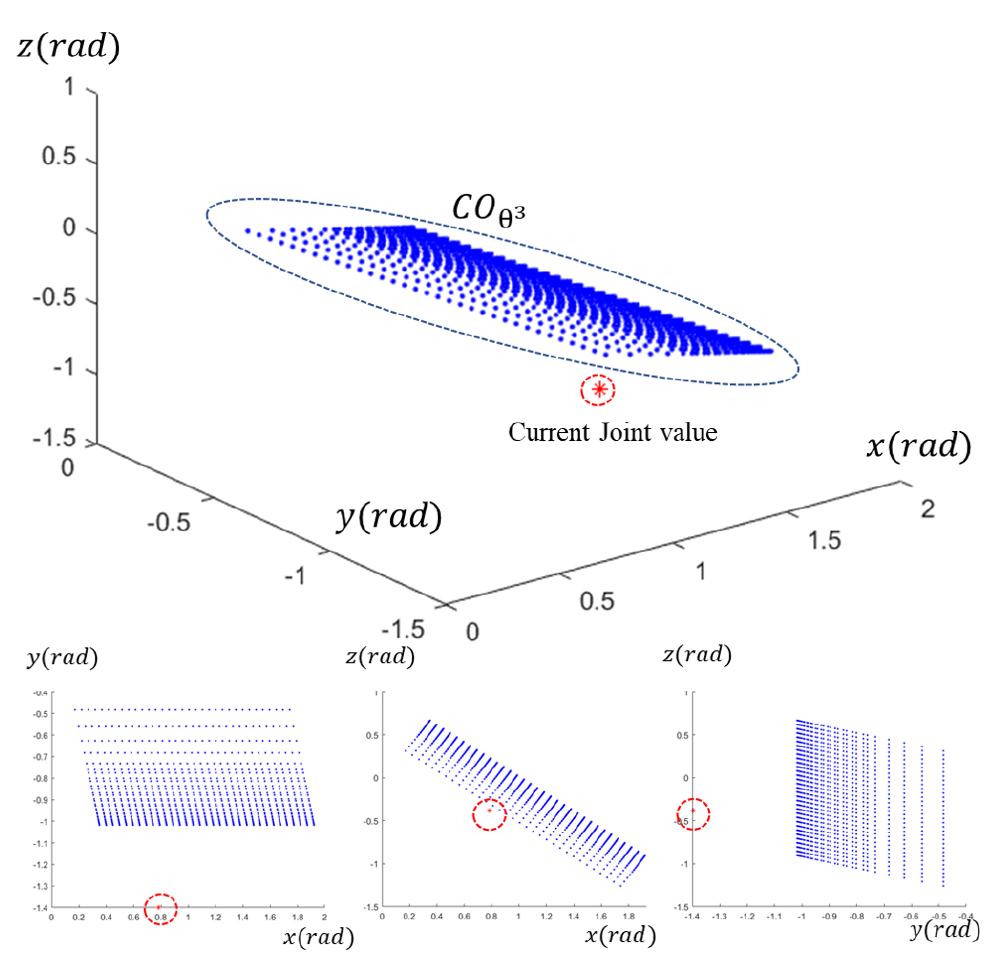
Figure 23. The resulting graph of the generated obstacle image in 3-dimensional space. The three bottom images are views of 2-dimensional space: x-y, x-z, and y-z. Figures 24–26 are 33 by 33 matrices about CO ij ( θ boom , B ) , CO ij ( θ stick , B ) , and CO ij ( θ bucket , B ) , respectively, from m and n chosen to be